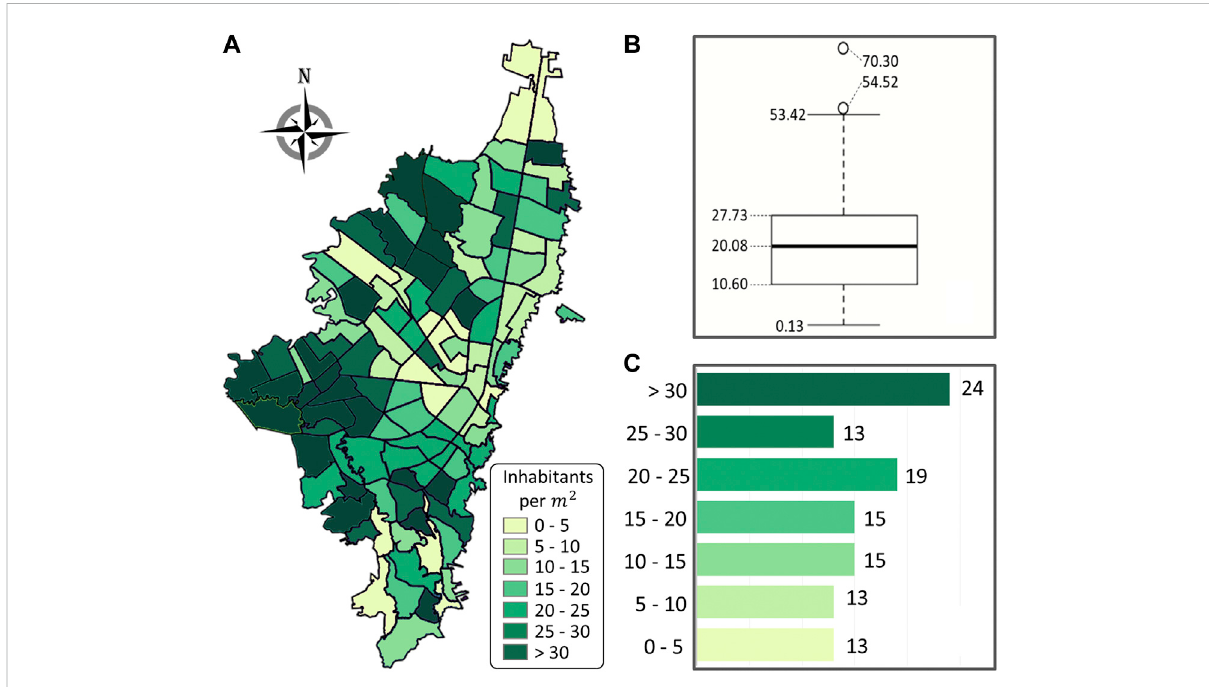
FIGURE 5 Population density across the 112 UPZs of Bogotá, in 2018. (A) map of spatial distribution of population density; (B) box-and-whiskers plot of UPZ population density values; (C) histogram of frequencies for the population density distribution across UPZs.